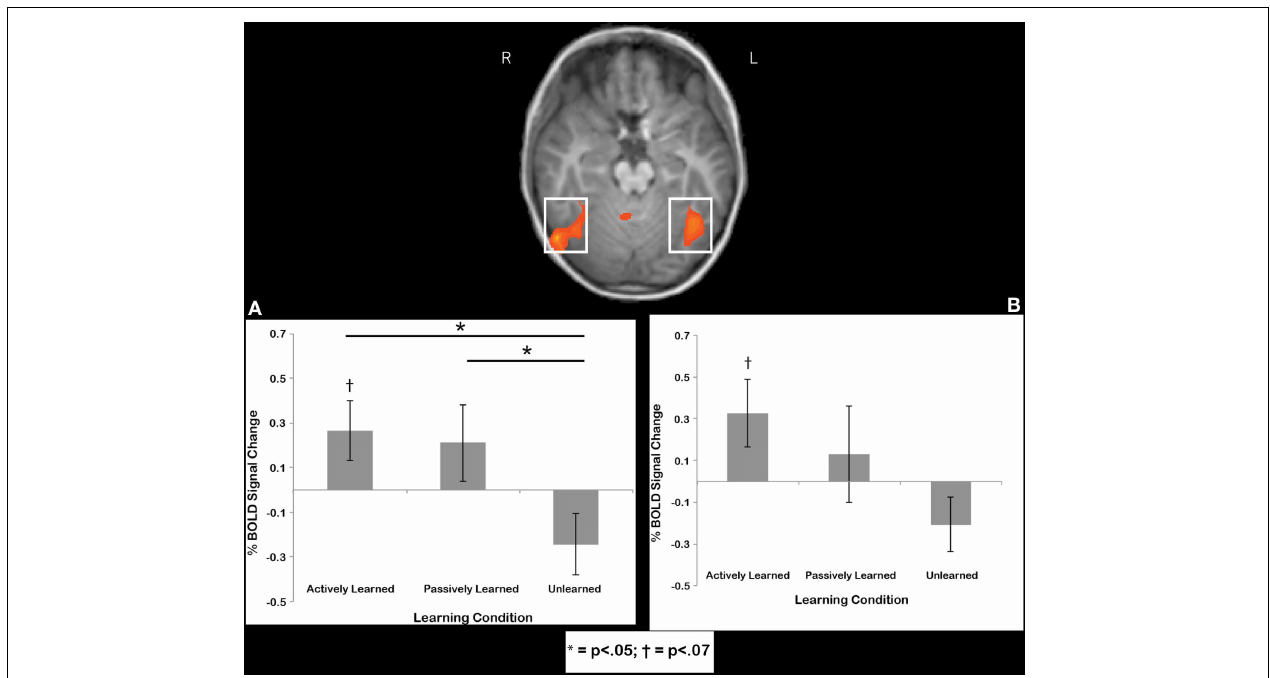
FIGURE 7 | Region of interest results for the right fusiform (A) and left fusiform (B). Trends were found for recruitment of the left and right fusiform above baseline in response to perception of actively learned letters.